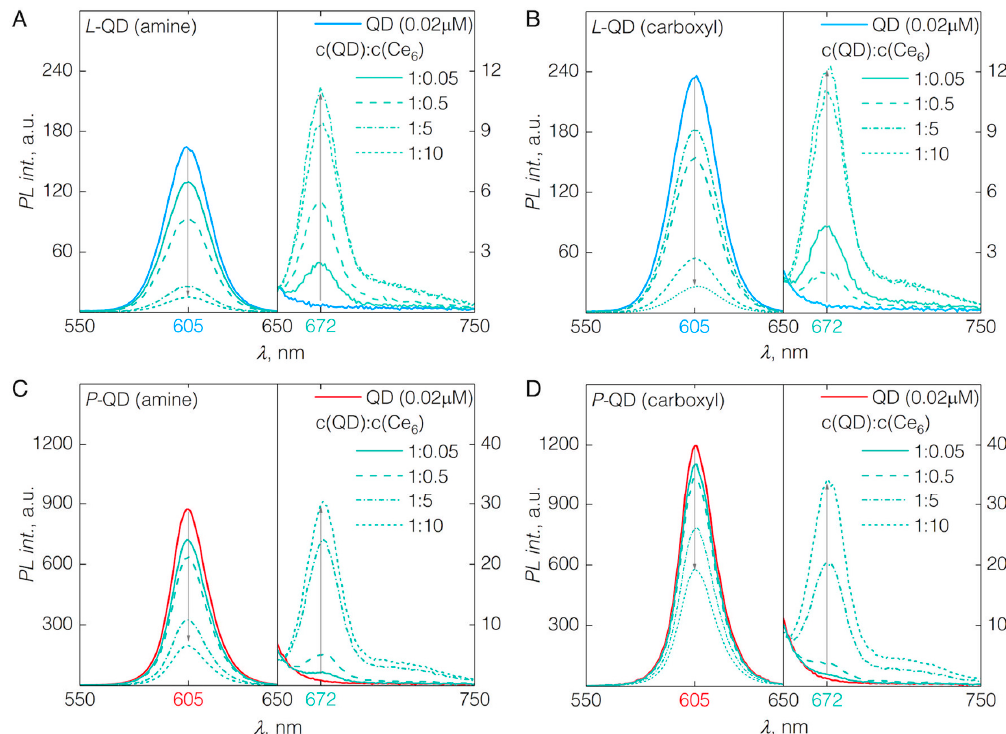
Figure 2. Emission spectra of pure QDs and respective QD-Ce 6 complexes varying the molar concentration ratio between QDs and Ce 6 from 1:0.05 to 1:10. Spectra were recorded under 465 nm excitation. ( A ) L -QD(amine)-Ce 6 ; ( B ) L -QD(carboxyl)-Ce 6 ; ( C ) P -QD(amine)-Ce 6 ; ( D ) P -QD(carboxyl)-Ce 6 .